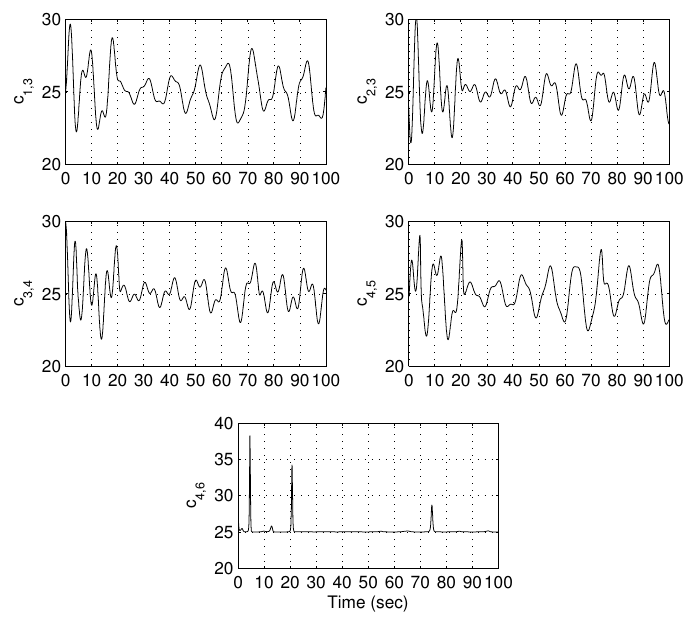
Figure 2. Couplings time-variation obtained from the solutions of the Generalized Rössler System in (cid:60) 5 , with an added offset.